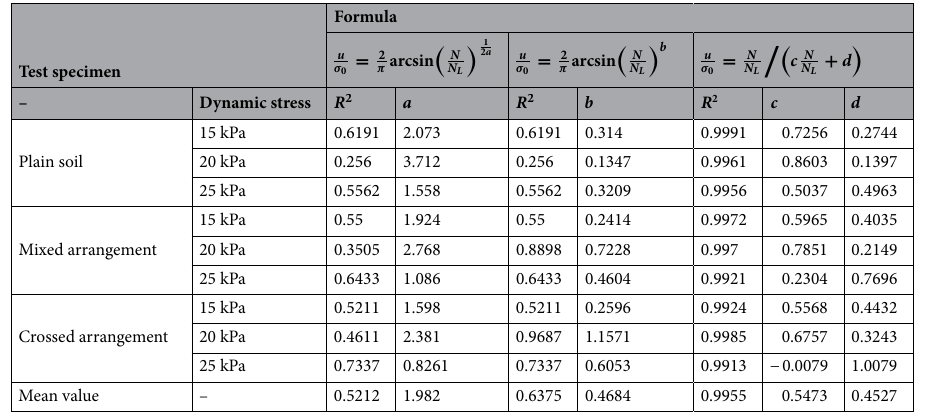
Table 3. Regression equation calculation